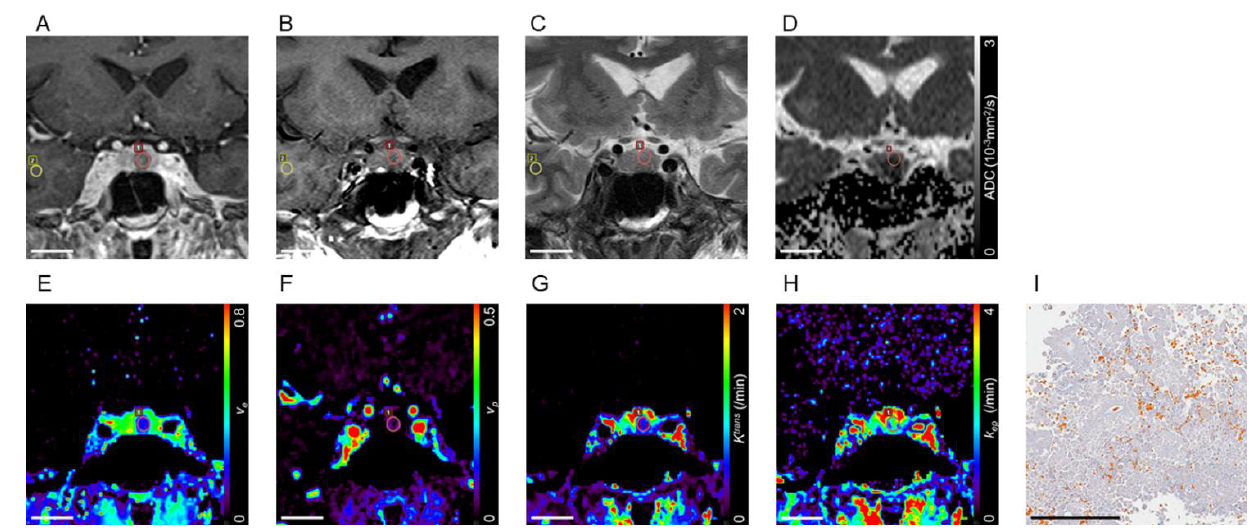
Figure 3. Pituitary adenoma with soft consistency. A contrast-enhanced coronal T1-weighted image of a pituitary microadenoma which maximum diameter is 6 mm ( A ). The adenoma is hypointense in the white matter on the T1-weighted image (rT1 = 0.796; B ) and hyperintense on the T2-weighted image (rT2 =1.422; C ). The corresponding ADC map shows a low ADC value (0.581 × 10 −3 mm 2 /s; D ). Parametric mapping shows a low v e value (0.205; E ), a low v p value (0.030; F ), a low K trans value (0.395/min; G ), and a high k ep value (1.900/min; H ) in the adenoma. Region of interests for tumor and normal-appearing white matter are indicated by red and yellow lines, respectively. Azan-stained section of tumor at pathologic examination shows scant collagen in the stromal fibrous tissue in blue within predominant tumor cells in red (PCC = 6.1%; I ). Bar indicates 20 mm ( A – H ), 200 µ m ( I ). rT1: ratio of signal intensity on T1-weighted MRI; rT2: ratio of signal intensity on T2-weighted MRI; ADC: apparent diffusion coefficient; v e : volume of extravascular extracellular space per unit volume of tissue; v p : blood plasma volume per unit volume of tissue; K trans : volume transfer constant between blood plasma and extravascular extracellular space; k ep : rate constant between extravascular extracellular space and blood plasma; PCC: percentage of collagen content.